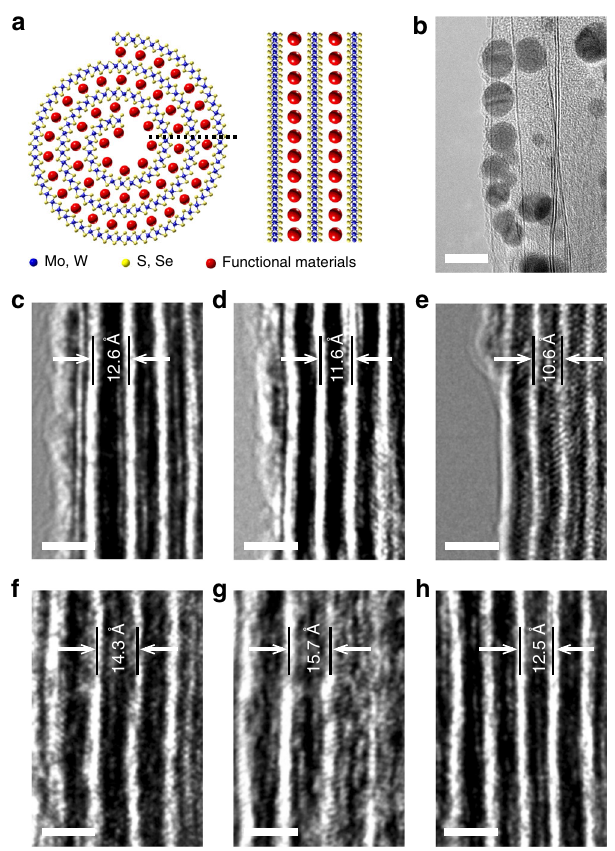
Fig. 5 Hybrid transition metal dichalcogenide (TMD)-nanoscrolls (NSs). a Schematic showing the cross section and sidewalls of hybrid TMD-NSs. b – h HR-TEM images of sidewalls of MoS 2 -NSs hybridized with AuNPs ( b ), GO ( c ), pentacene ( d ), CuPc ( e ), PDPP3T ( f ), DNA ( g ) and polypeptide ( h ). AuNPs approximately 5 nm in diameter were clearly observed between the walls; the GO fl akes were also distinguishable, as shown in c . Lattice expansion was displayed in all hybrid NSs above. The bright white walls represent the MoS 2 layers in ( c – h ) (scale bars, 10 nm in b and 2 nm in c – h